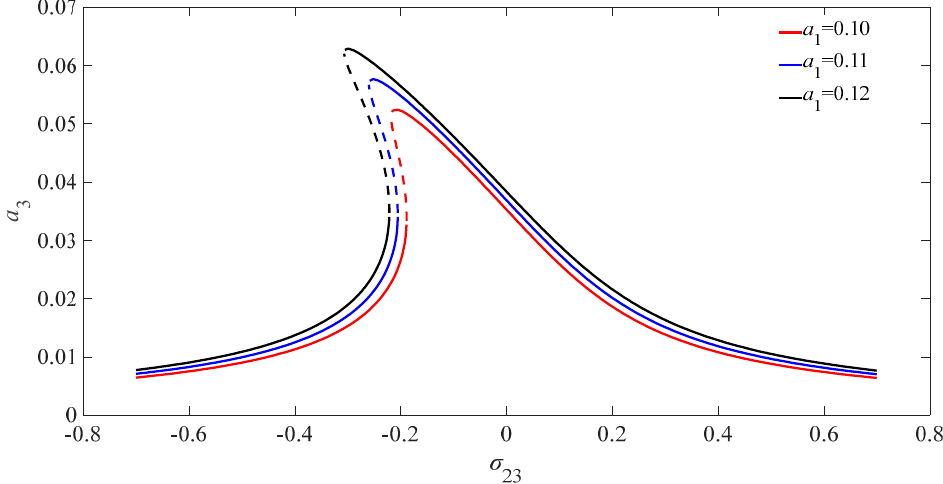
Figure 4. Diagram of internal resonant amplitude-frequency of nanobeam for different amplitudes of PDJJ.